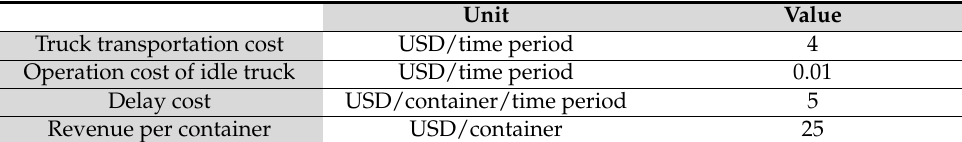
Table 5. Standard costs and fees [8].